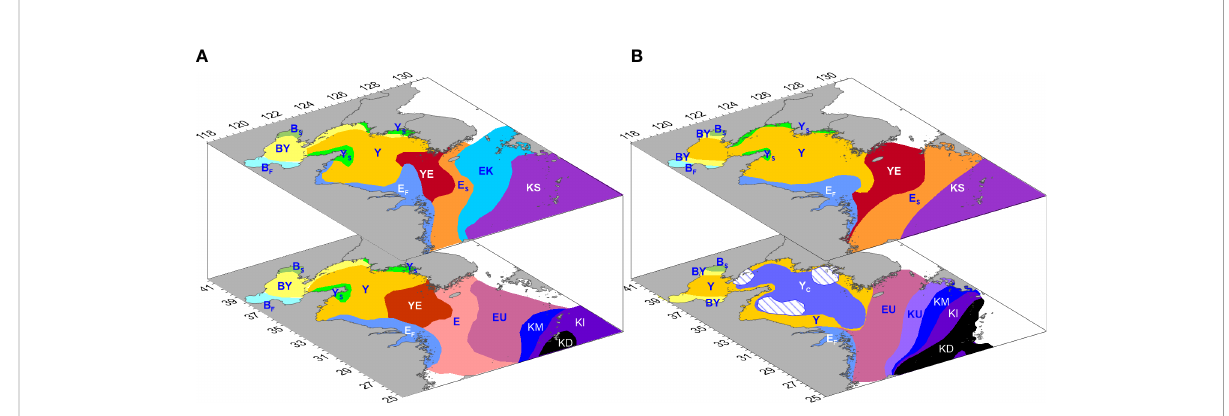
FIGURE 2 Water mass distribution in surface and bottom layers of the Bohai Sea, the Yellow Sea and the East China Sea in (A) winter and (B) summer. Yellow- BY , Dull green- BS , Ice blue- BF , Deep yellow- Y , Green- YS , Electric blue- YC , Baby blue- EF , Red- YE , Orange- ES , Bright blue- EK , Violet- KS , Pink- E , Dusty rose- EU , Light violet- KU , Blue- KM , Dark violet- KI , Black- KD . Shadow areas- YC cold centers. (Redrawn and integrated from: Su et al., 1983; Qiu et al., 1984; Miao et al., 1987; Li et al., 1989a; Lu, 1989; Zhang et al., 1996; Pan and Huang, 1997; Li and Su, 2000).